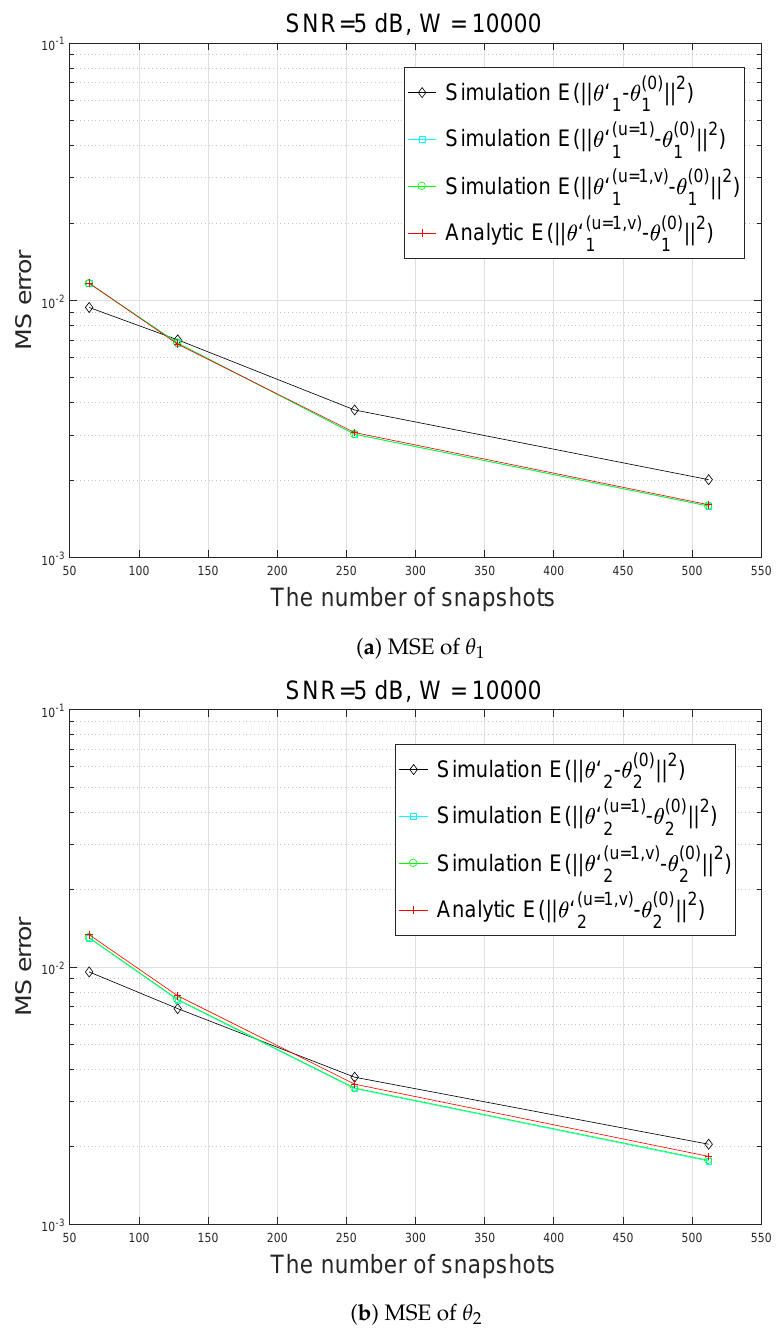
Figure 3. Analytic and simulated MSEs θ 1 and θ 2 with respect to the number of snapshots (SNR = 5